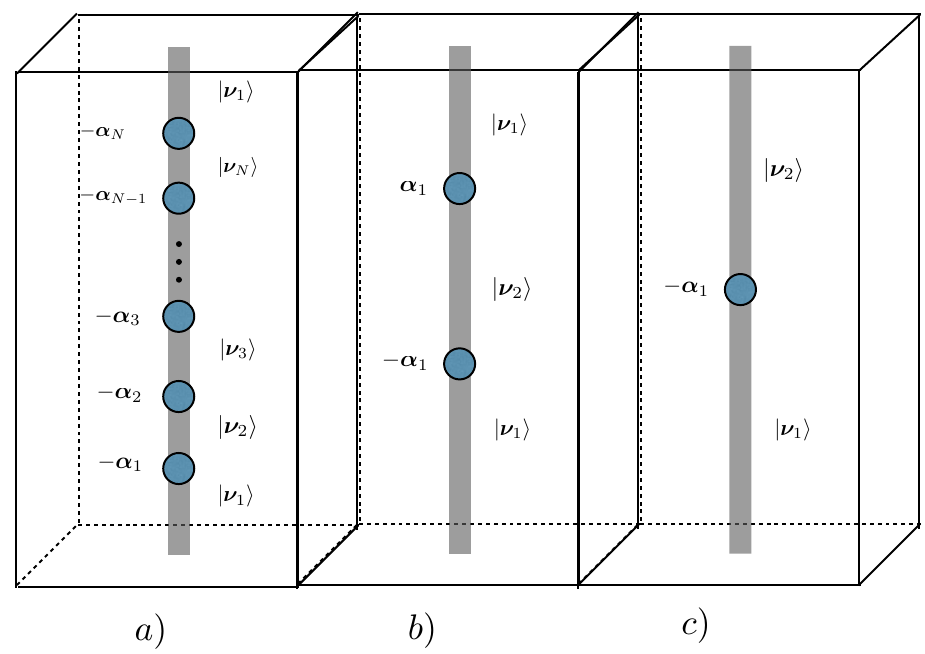
R B (2) = ‘ = 1 unit of ’t Hooft flux, Z Figure 6 . Consider YM in the background of N 12 12 2 π tr [e − βH ‘ ] . The existence of ‘ = 1 , in finite volume, leads to N -perturbatively degenerate minima, 12 12 just like T QM model. a) A non-trivial periodic (in Euclidean time) configuration with topological N charge W = − 1 contributing to Z is a collection of N dynamical monopole instantons, each of ‘ 12 which have zero ’t Hooft charge, but non-zero magnetic charge. b) A periodic configuration with topological charge W = 0 contributing to Z . c) This configuration does not contribute to Z ‘ 12 as it is not periodic in Euclidean time, but it contributes to the sum over transition amplitudes, = tr [e − βH ‘ ( U ) ‘ 34 ] , ‘ = 1 . The aperiodicity in the euclidean time direction can also be Z ‘ 12 c 34 12 ‘ 34 R B (2) undone, and replaced with an N = ‘ = 1 34 34 2 π